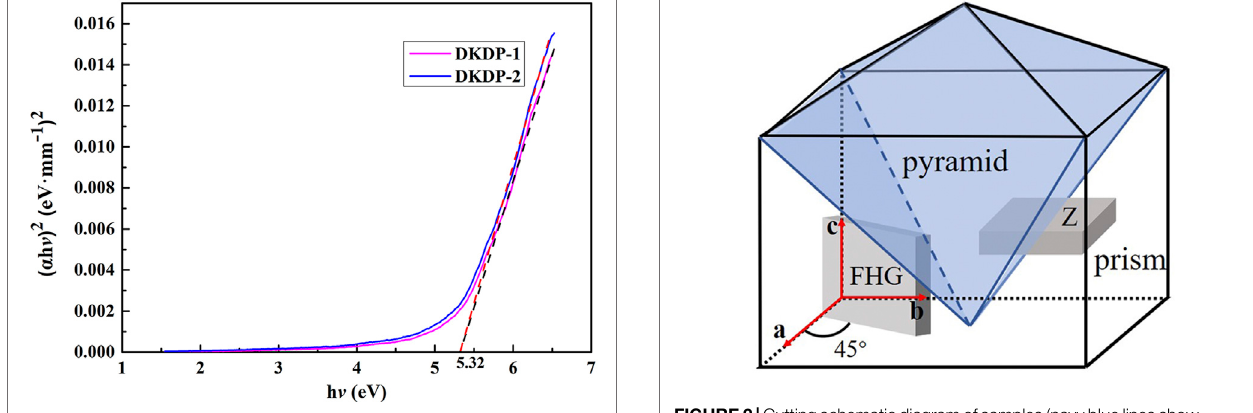
FIGURE 1 | The relationship between hv and ( α hv) 2 of 98% DKDP crystal.